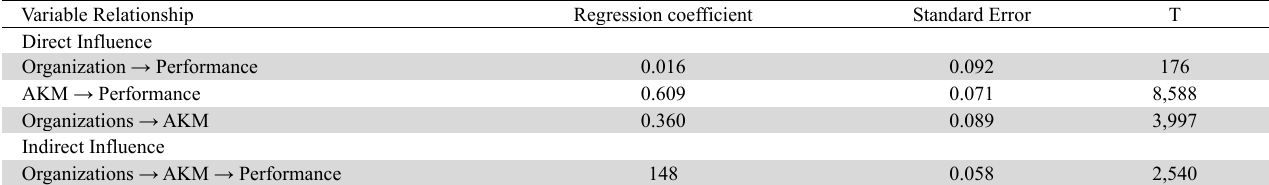
Sobel Test Results on the Hypothesis Model